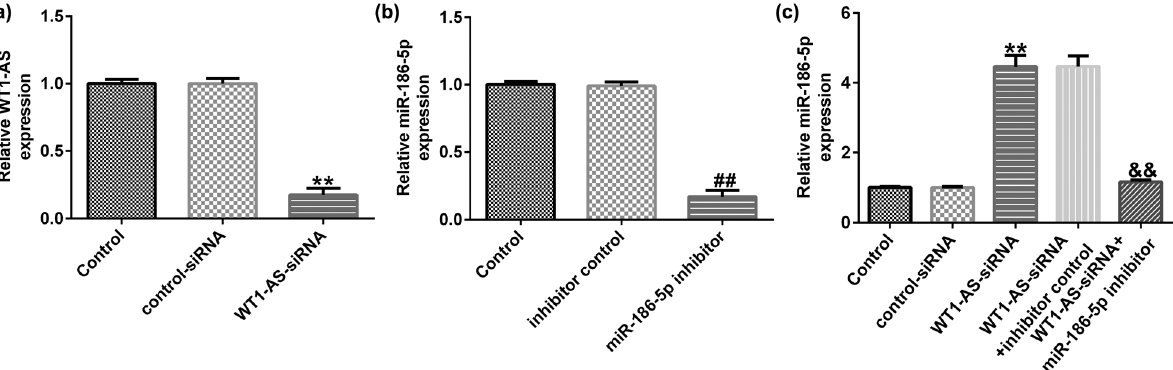
Figure 4: WT1 - AS knockdown upregulates miR - 186a - 5p expression in HTR - 8/SVneo cells. ( a ) qRT - PCR analysis of WT1 - AS in HTR - 8/SVneo cells transfected with control siRNA or WT1 - AS siRNA. ( b ) Determination of miR - 186 - 5p levels in HTR - 8/SVneo cells transfected with inhibitor control or miR - 186 - 5p inhibitor. ( c ) mRNA expression of miR - 186 - 5p in HTR - 8/SVneo cells transfected with control siRNA, WT1 - AS - siRNA, WT1 - AS - siRNA + inhibitor control, or WT1 - AS - siRNA + miR - 186 - 5p inhibitor was determined using qRT - PCR. ** P < 0.01 vs control siRNA; ## P < 0.01 vs inhibitor control; && P < 0.01 vs WT1 - AS - siRNA + inhibitor control. WT1 - AS, WT1 antisense RNA; miR, microRNA; RT - qPCR, reverse transcription - quantitative PCR; si, small interfering.